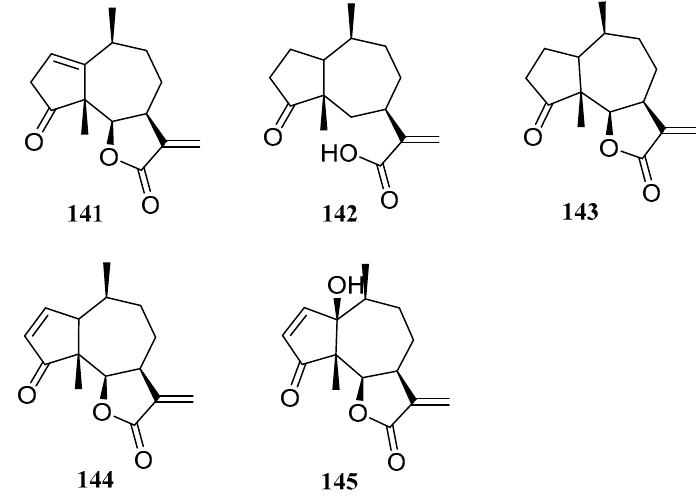
Figure 13. Structures of pseudoguaiane - type sesquiterpenoids 141 – 145 .